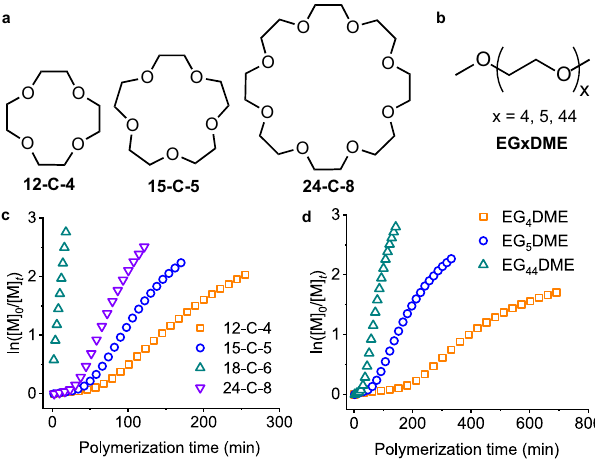
Fig. 2 Structural impact of CE and its analogs on the catalysis. a Chemical structures of CEs. b Chemical structures of LE analogs. c Semilogarithmic kinetic plot of polymerization of BLG-NCA in DCM initiated by Hex-NH 2 in the presence of various CEs. d Semilogarithmic kinetic plot of polymerization of BLG-NCA in DCM initiated by Hex-NH 2 in the presence of various LE analogs. [M] 0 /[I] 0 = 100, [I] 0 = [CE/LE] 0 = 0.5